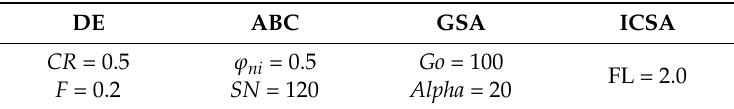
Table 2. Algorithms